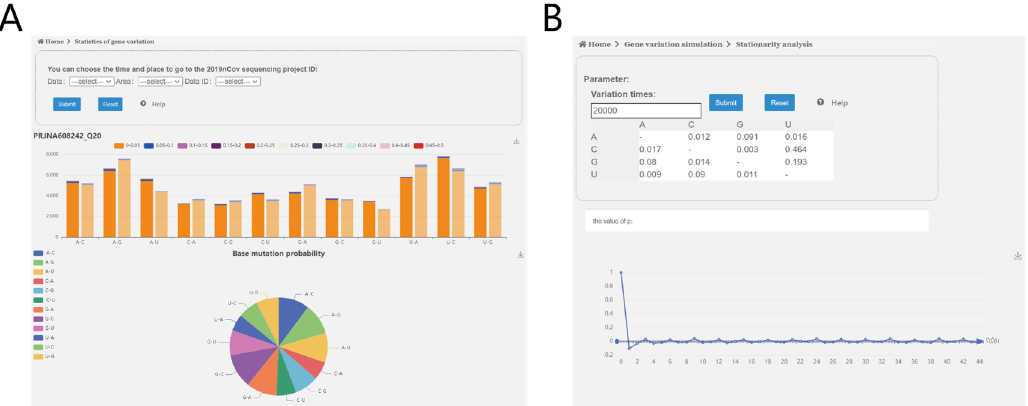
Figure 9. The webpage of 2019-NCSS. ( A ) The “mutation spectra analysis” module. ( B ) The “mutation simulation” module.